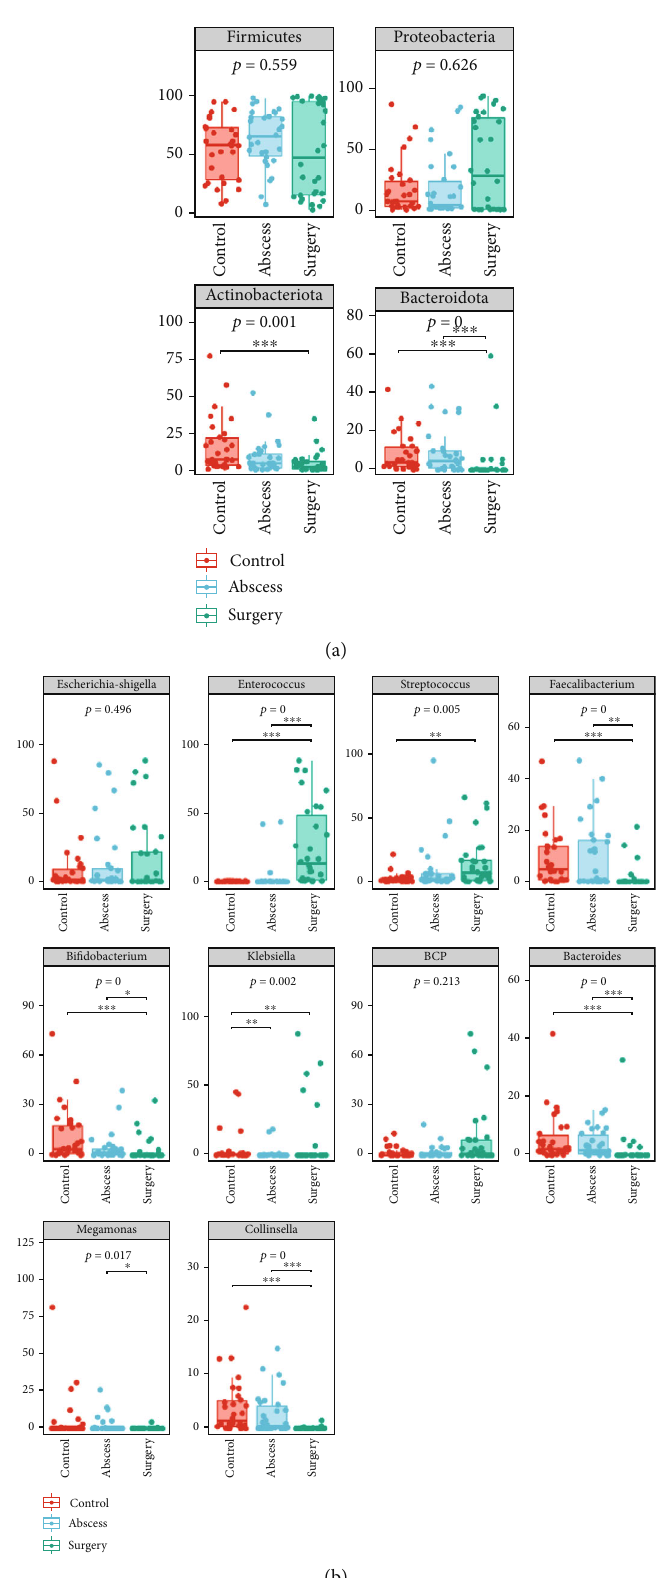
Figure 6: Statistical analysis of the di ff erences in the relative abundances of bacteria at (a) phylum level and (b) genus level. The p values of the overall di ff erences among the groups were obtained using the Kruskal-Wallis nonparametric test, and the signi fi cance level of the di ff erences was obtained using Dunn ’ s test after the pairwise comparisons between the groups ( ∗ p < 0 : 05 , ∗∗ p < 0 : 01 , and ∗∗∗ p < 0 : 001